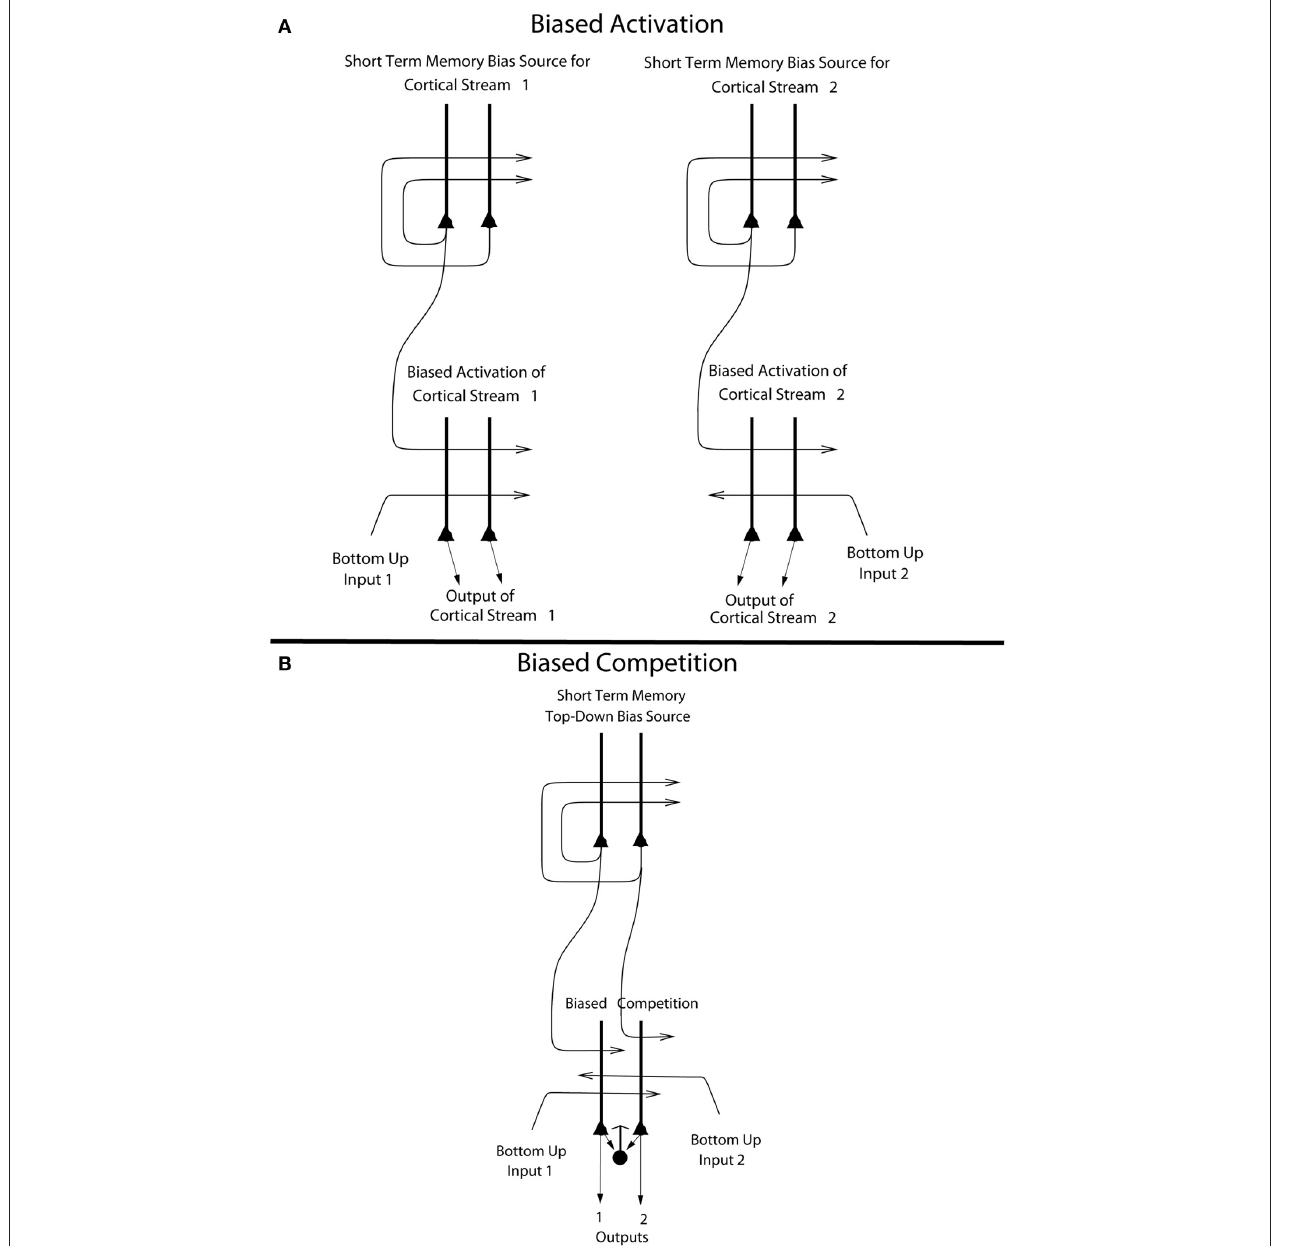
FIGURE 6 | (A) Biased activation. The short-term memory systems that provide the source of the top-down activations may be separate (as shown), or could be a single network with different attractor states for the different selective attention conditions. The top-down short-term memory systems hold what is being paid attention to active by continuing firing in an attractor state, and bias separately either cortical processing system 1, or cortical processing system 2. This weak top-down bias interacts with the bottom up input to the cortical stream and produces an increase of activity that can be supralinear (Deco and Rolls, 2005b). Thus the selective activation of separate cortical processing streams can occur. In the example, stream 1 might process the affective value of a stimulus, and stream 2 might process the intensity and physical properties of the stimulus. The outputs of these separate processing streams then must enter a competition system, which could be for example a cortical attractor decision-making network that makes